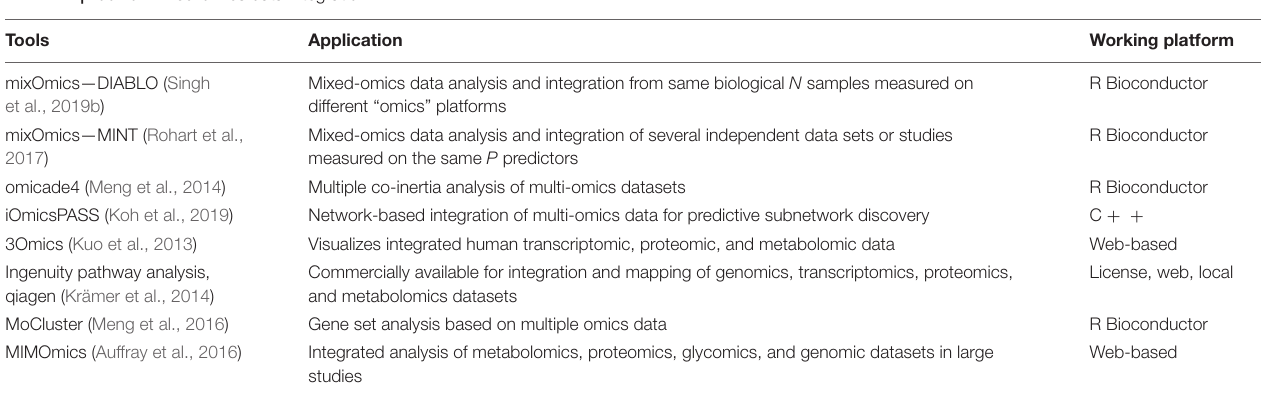
TABLE 1 | Tool for mixed-omics data integration.